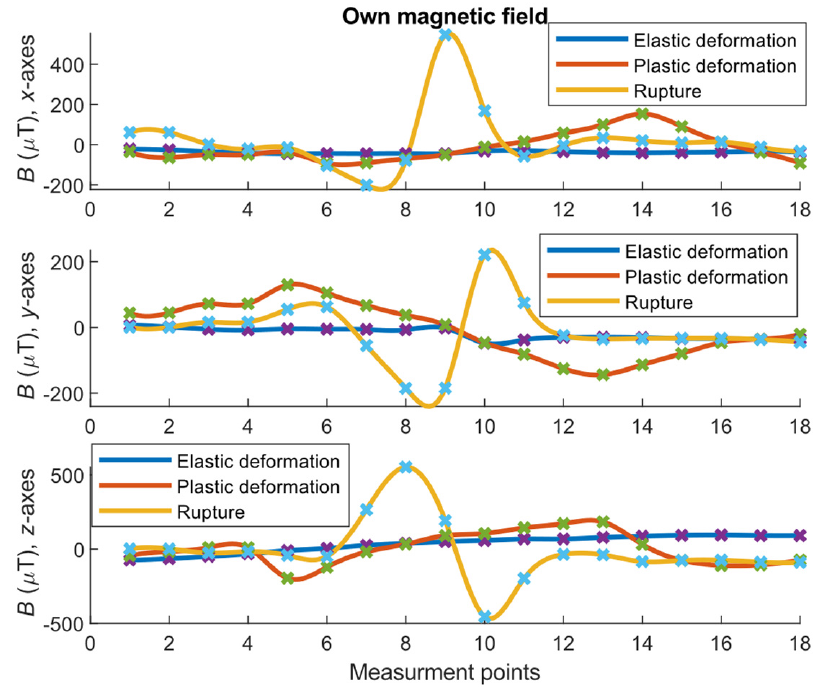
Figure 8. Reversible and irreversible effects associated with different states of the sample strain at successive points on the specimen’s surface (measurement points). The x , y , and z charts correspond to measurements from the x -, y -, and z -axes of magnetic sensors, respectively. The x -axis direction was tangential to the main axis of the sample, and the z -direction was normal to the sample surface.